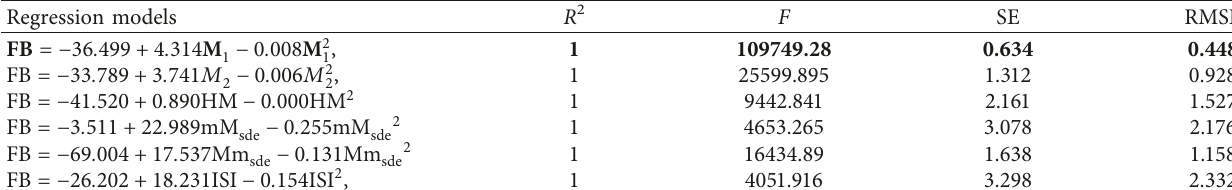
Table 8: The quadratic regression models that give the best estimate for the flashpoint. Regression models